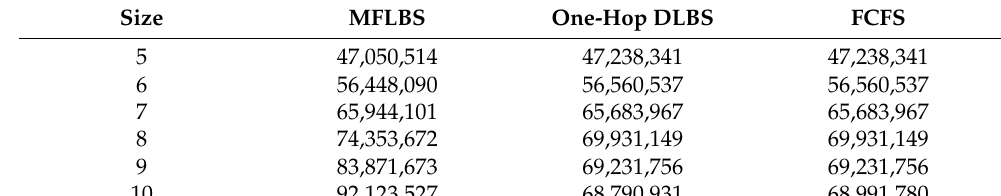
Table 5. Average throughput (MB) in FPN model under uniform pattern.